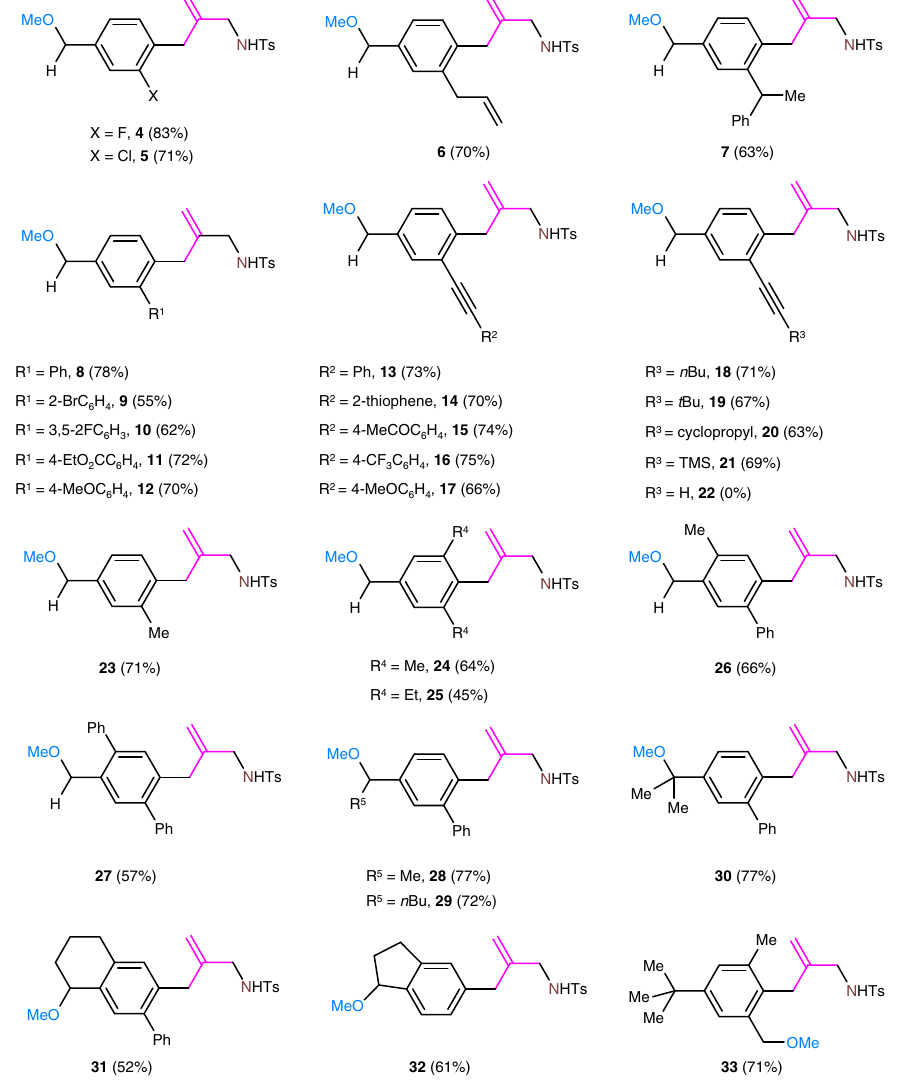
Fig. 3 Substrate scope investigation. Evaluation of the in fl uence of substituent groups of anilines